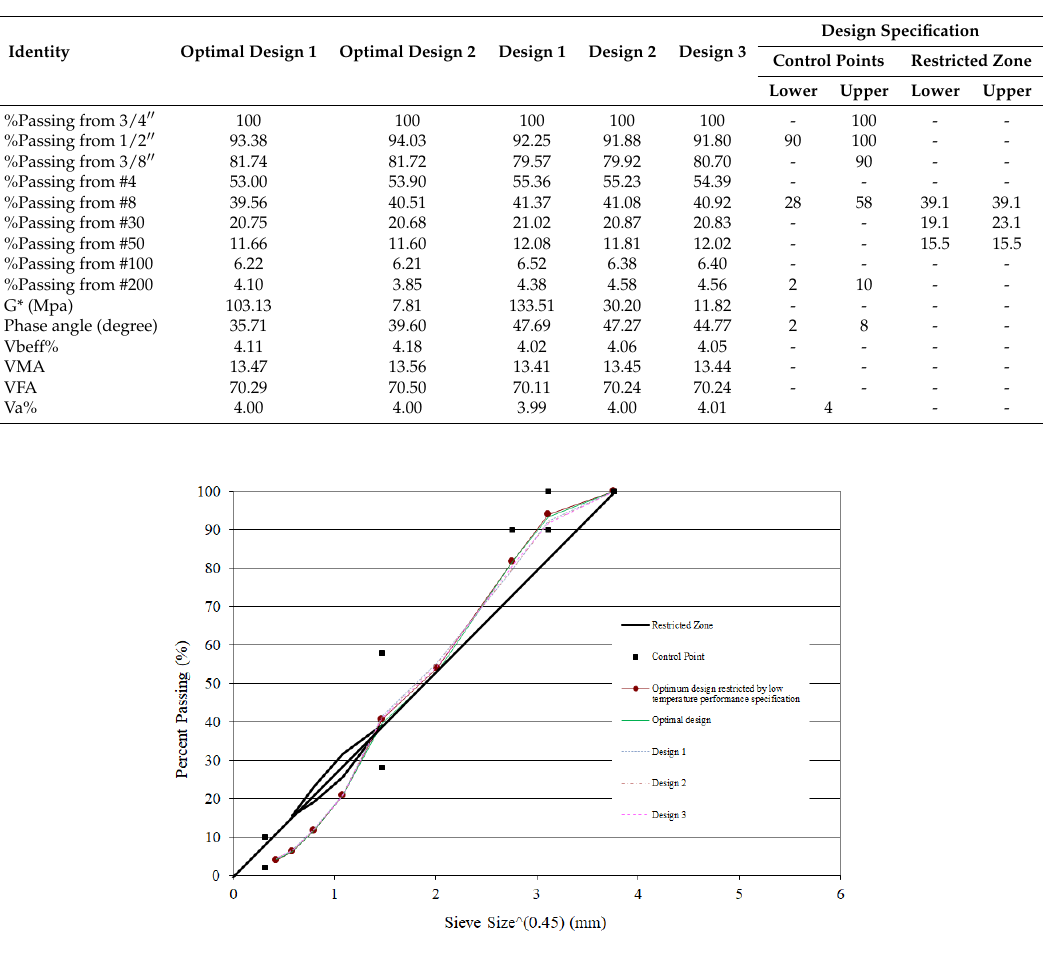
Figure 11. Aggregate gradation graphs with 12.5 mm NMAS particle size distribution obtained from